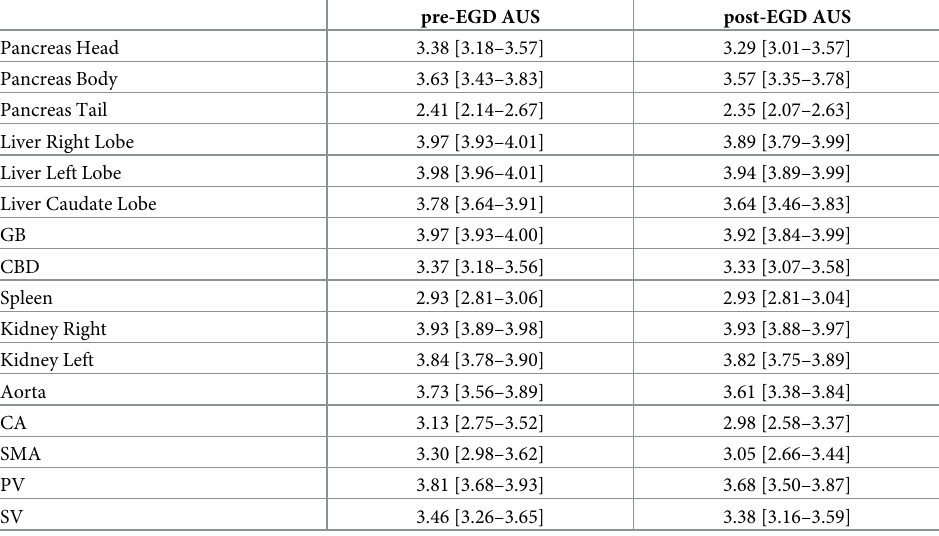
Table 2. Means and 95% CIs of image quality score for each organ at pre- and post-EGD AUS. pre-EGD AUS post-EGD AUS Pancreas